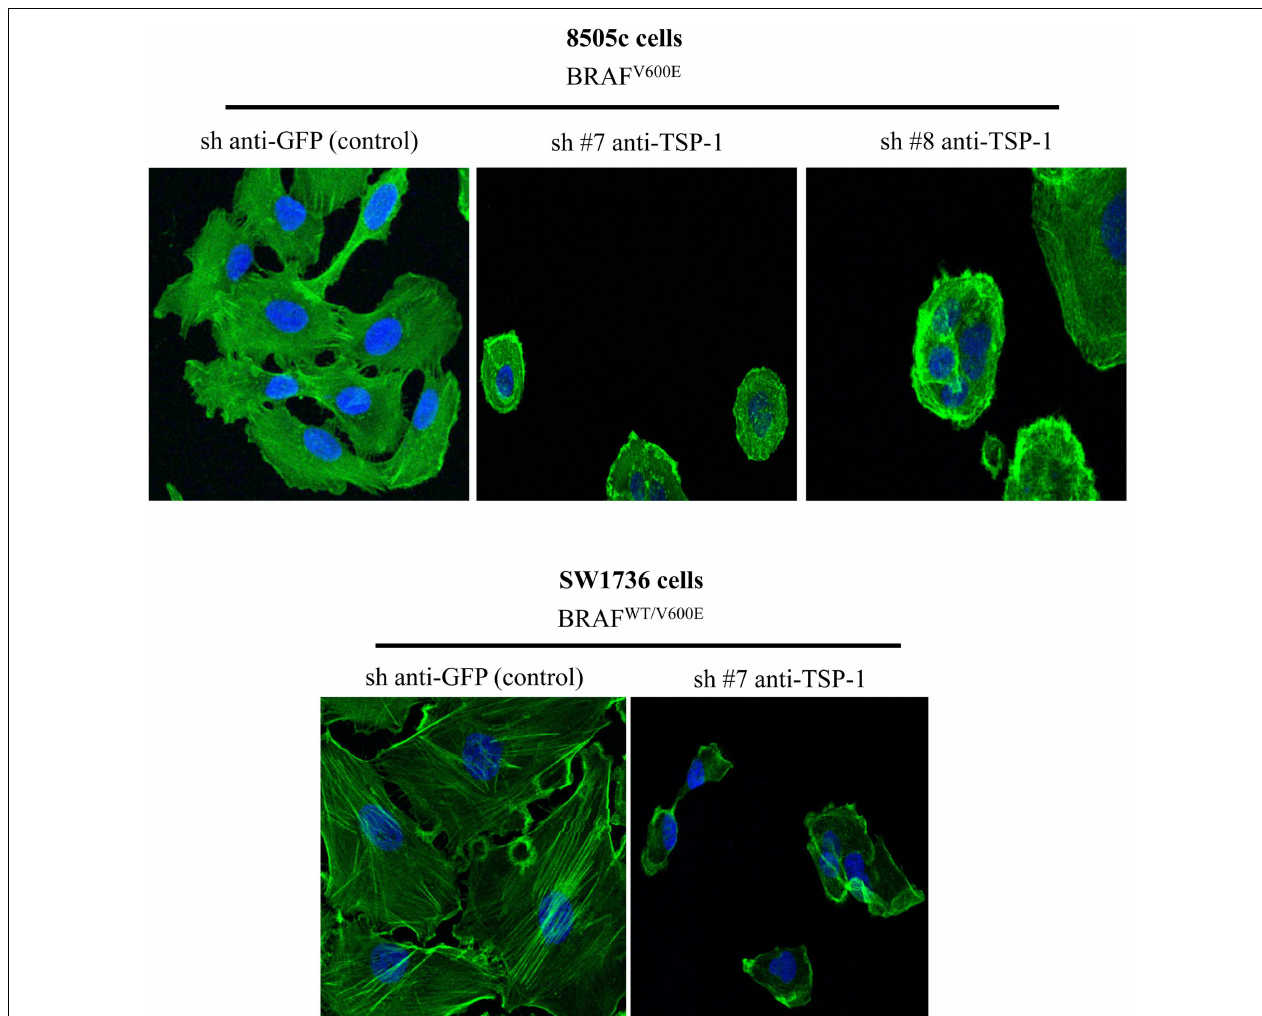
FIGURE 2 | Phalloidin staining in the control (sh-GFP) 8505c human anaplastic thyroid cancer (ATC) cells or in the 8505cATC cells withTSP-1 knock-down (sh-TSP-1), and in the sh-GFP (control) SW1736ATC cells or